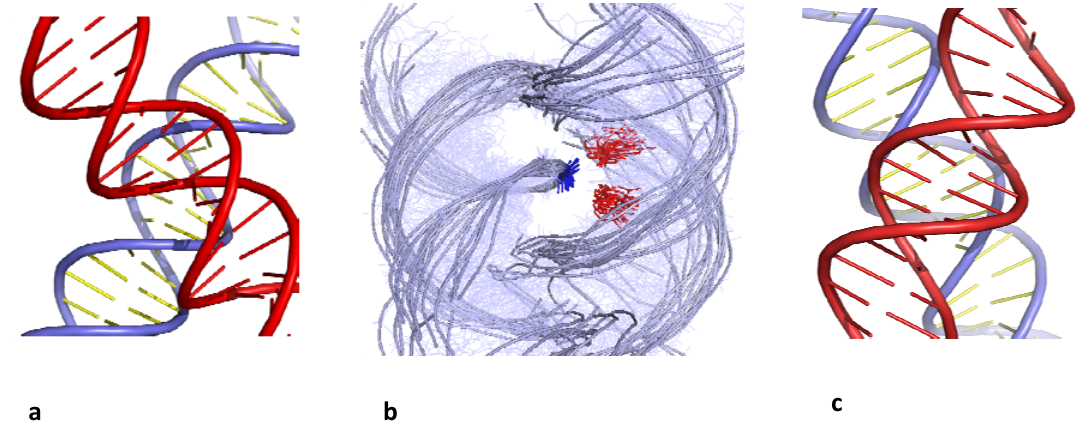
Figure 1. Chiral B-DNA crossovers. ( a ) Right-handed crossover assembled by the mutual fit of the backbones into the major-groove ( b ) superimposition of right-handed crossovers found in the PDB. They are all stabilized by cytosine (red) phosphate group (blue) interaction; ( c ) left-handed crossover assembled by major groove-major groove